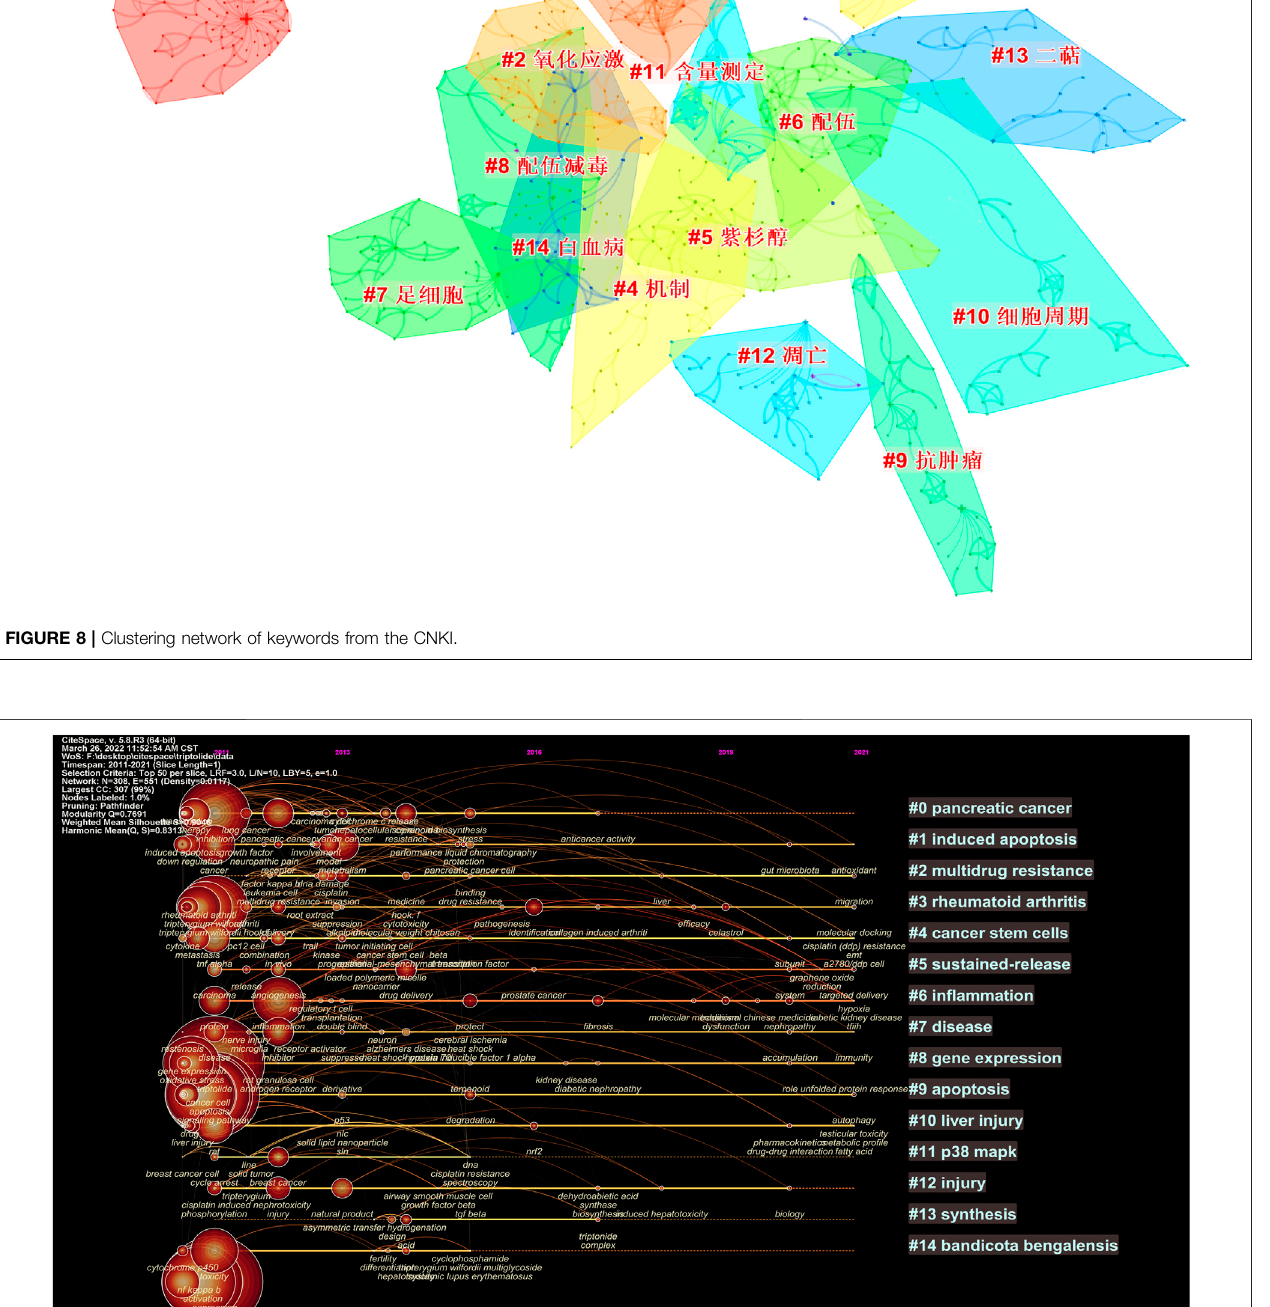
Frontiers in Pharmacology |